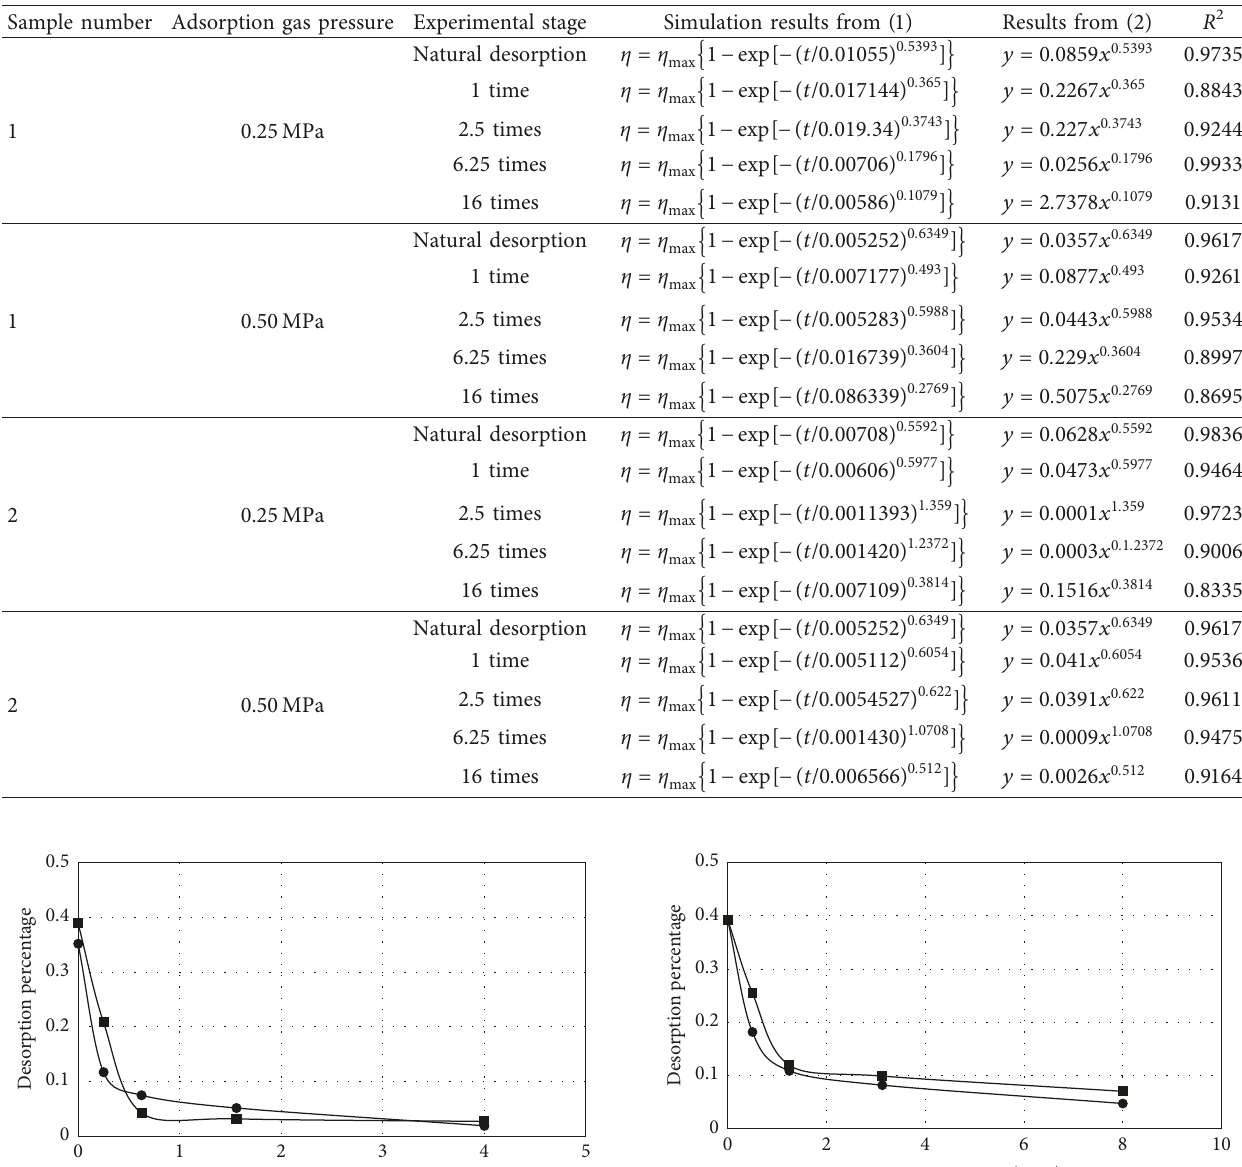
Table 4: Simulation results of time effect on desorption.